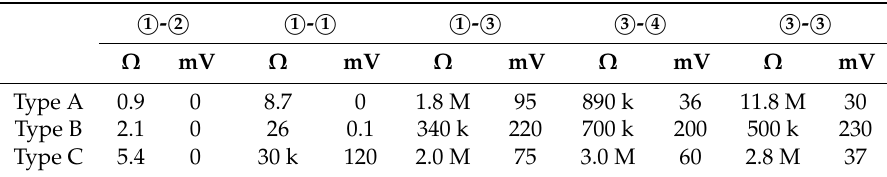
Table 2. The electric resistance and induced voltage by connecting different points of MCF rubber: Ω designates electric resistance and mV the induced